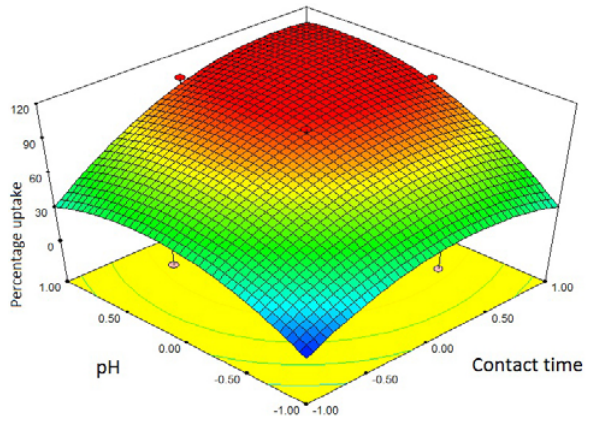
Figure 9. 3D surface plot for uptake of MB as a function of pH and contact time.